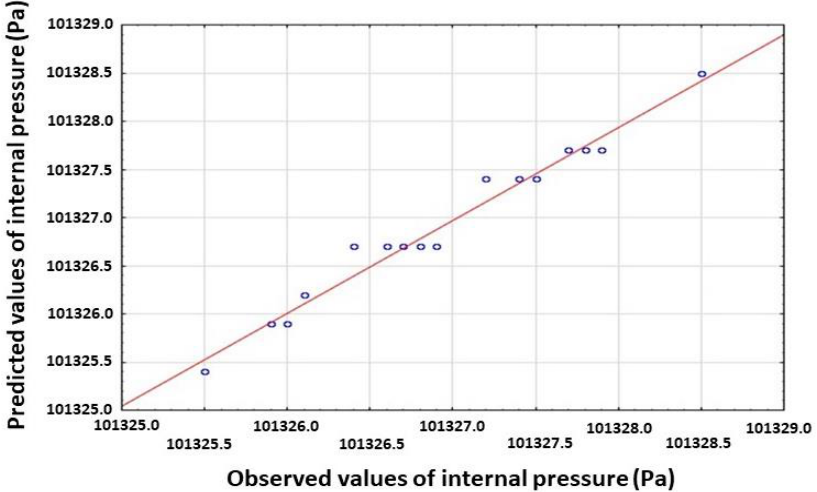
Figure 19. Predicted versus observed values of internal pressure in the reaction cell with lateral air inlet and outlet geometry.